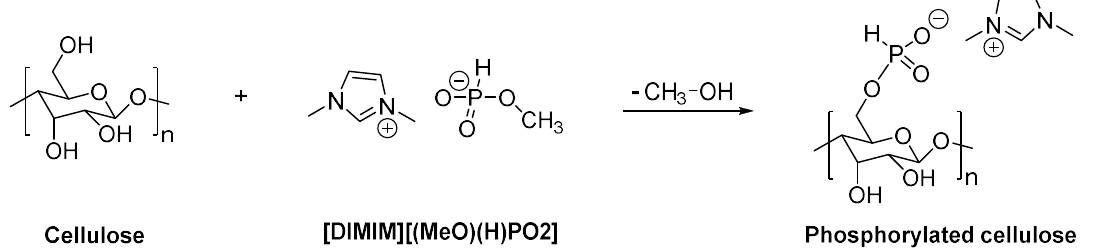
Figure 1. The reaction mechanism of the transesterification reaction of cellulose and [DIMIM][(MeO)(H)PO 2 ], according to Vo et al. [16]